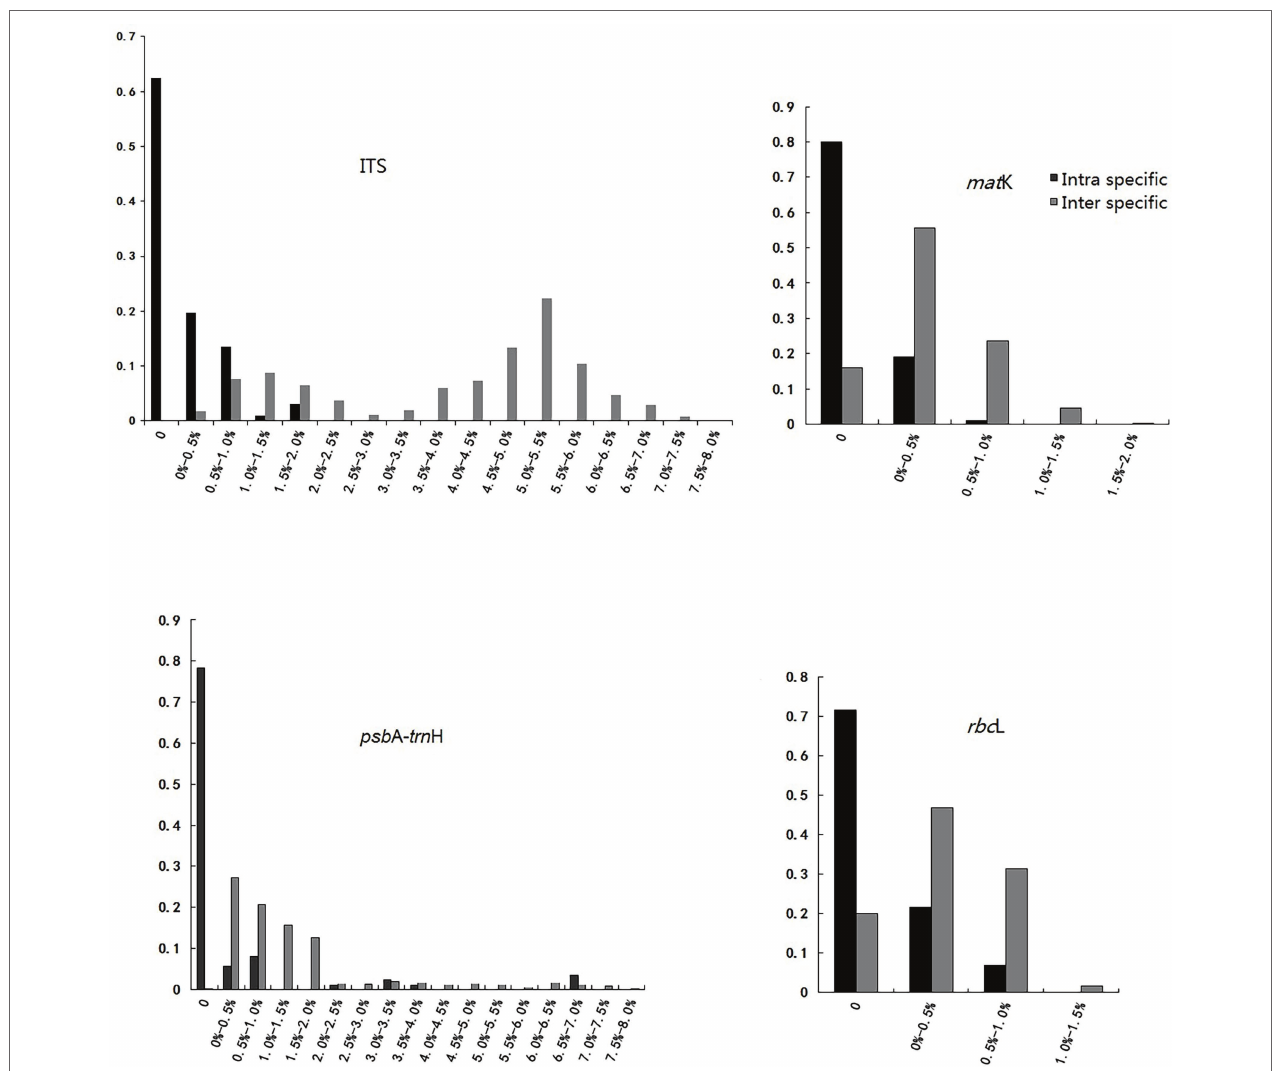
FIGURE 1 | “Barcoding Gap” of each single candidate